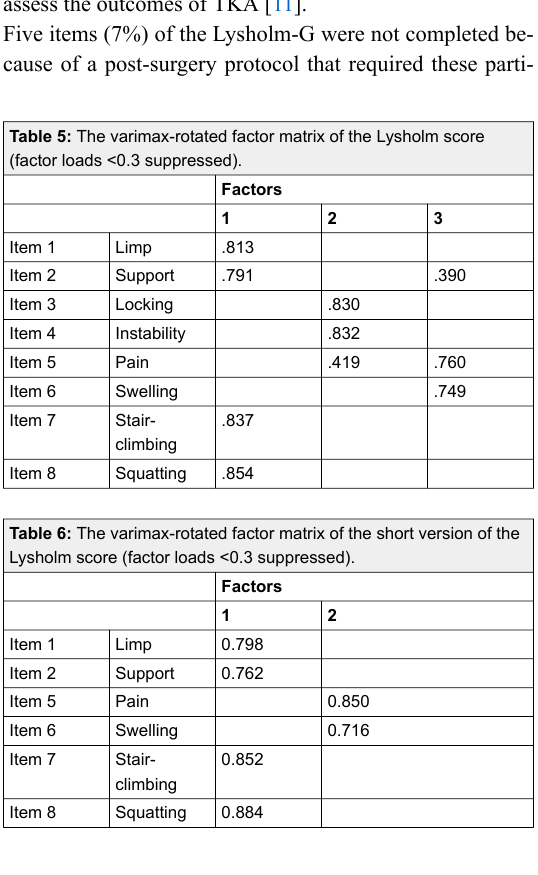
Spearman’s ρ coefficient values showed moderate correla-